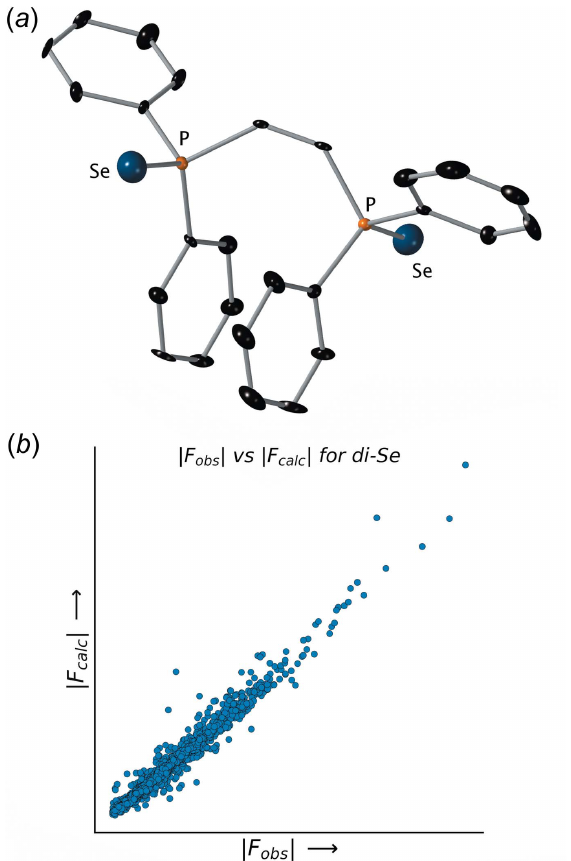
Figure 3 ( a ) An ellipsoid (50% probability) plot for the di-selenide model. Note the unrealistically large ellipsoids at the chalcogen sites and the small highly eccentric ellipsoids for the carbon atoms. ( b ) A plot of | F obs | vs | F calc | values for the di-selenide model. Note the extent of scatter in the plot.